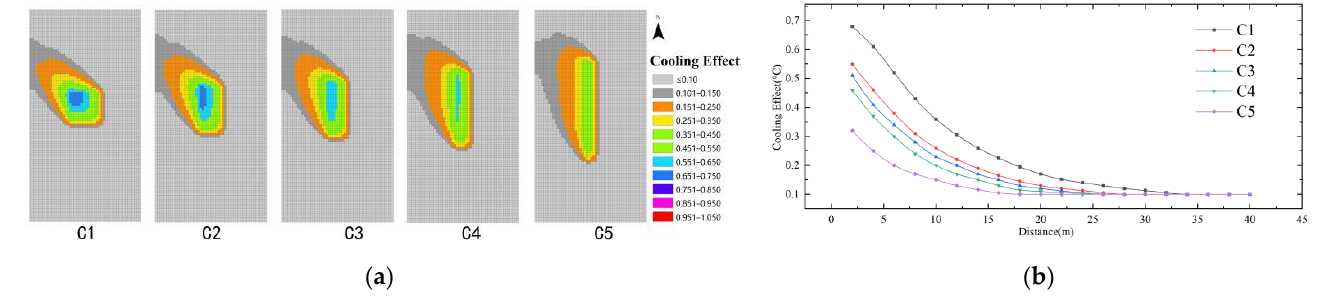
Figure 14. Cooling effect of the shape index of the water body: ( a ) Impact distribution map; ( b ) Impacts with distance.